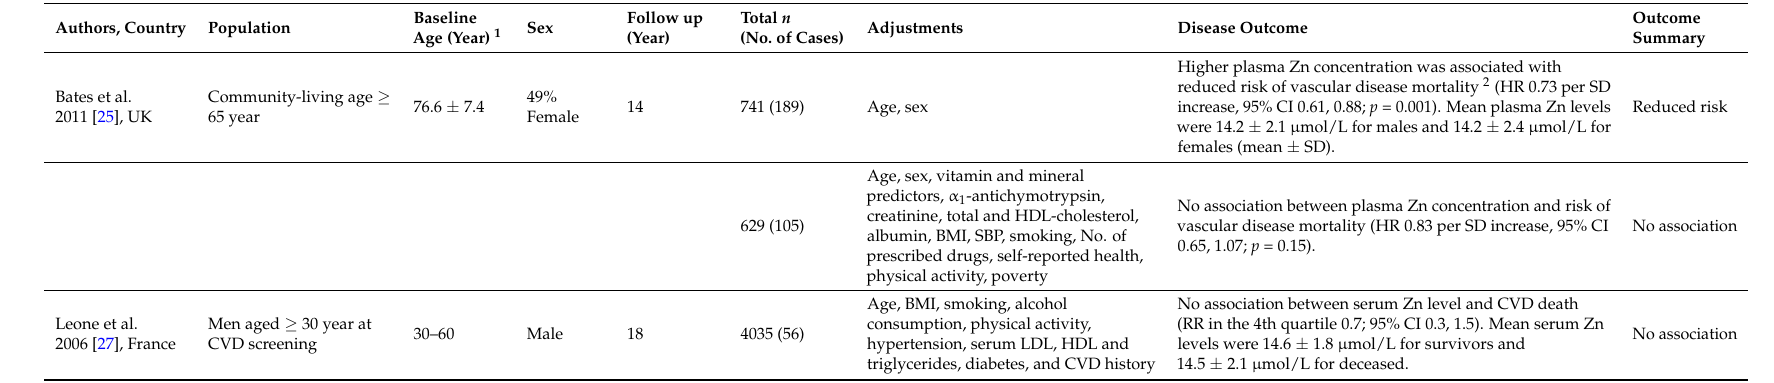
Table 2. Relationship between serum zinc levels and cardiovascular disease events in prospective cohort